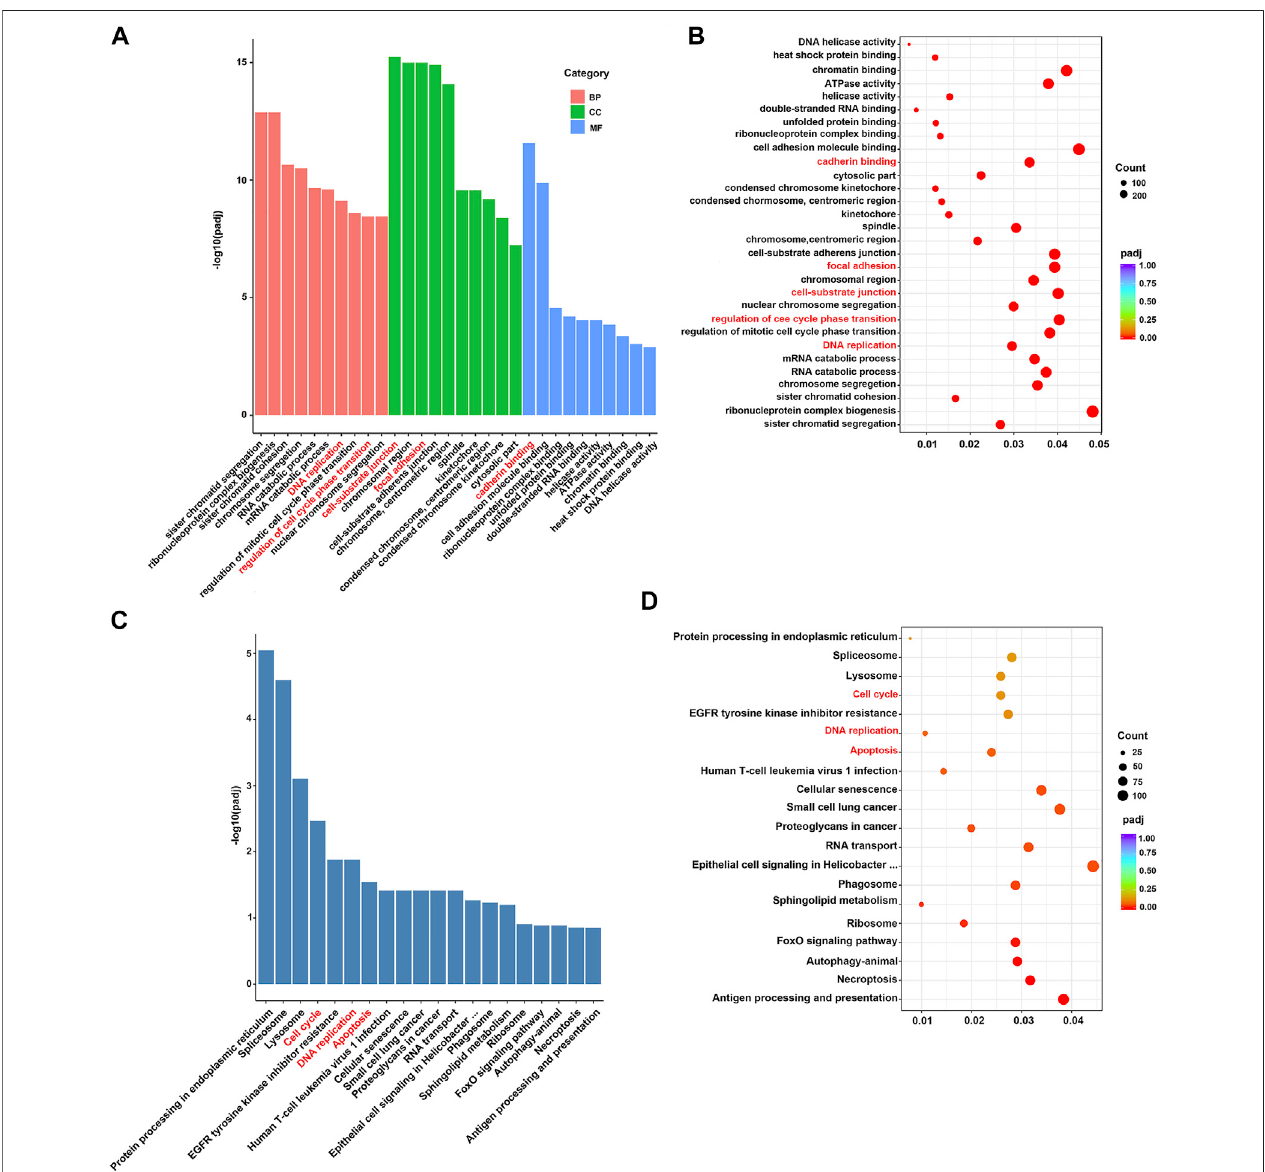
FIGURE 5 | (A,B) GO functional enrichment analysis of DEGs. (C,D) KEGG pathway analysis of DEGs.